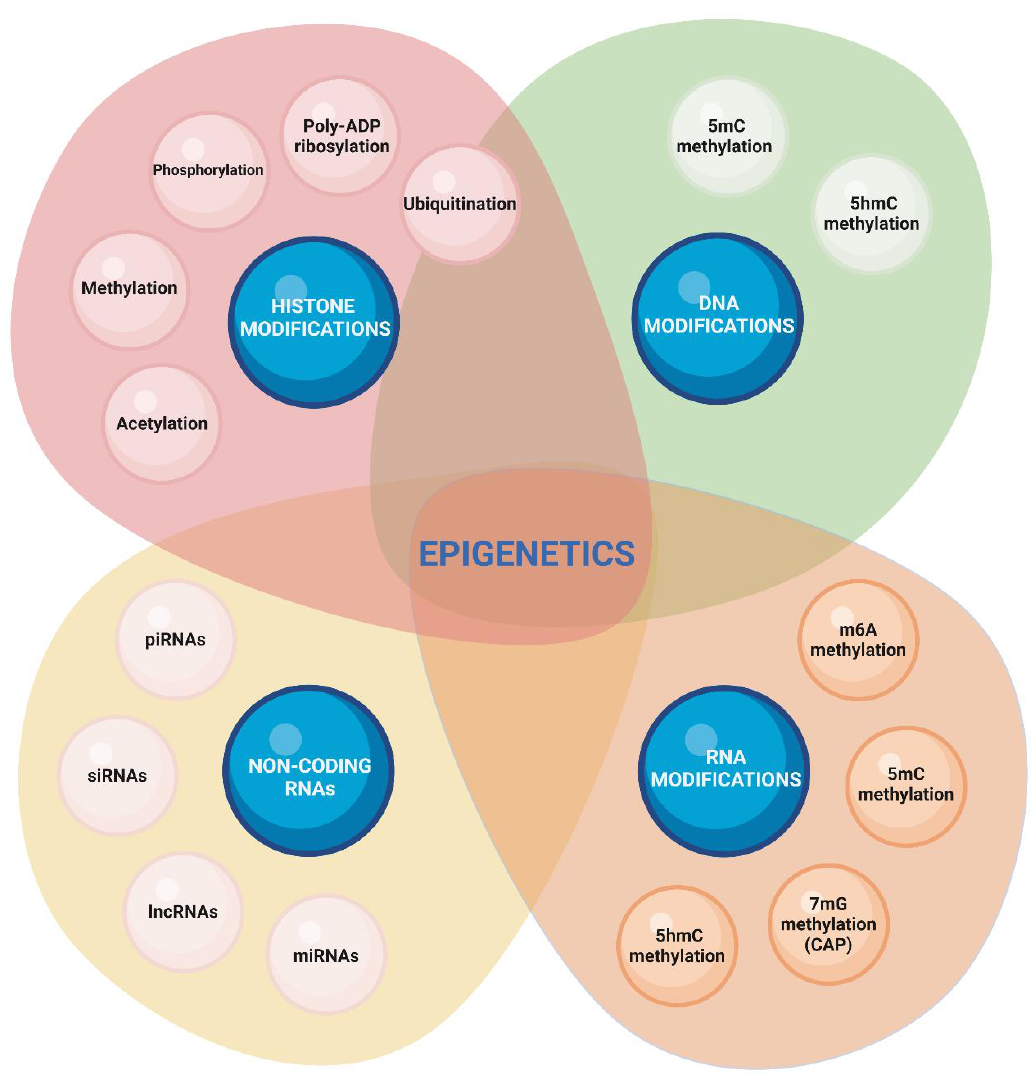
Figure 1. Epigenetic modifications: This diagram shows the complexity of epigenetic processes, which are divided into the following subgroups: DNA modifications — 5-methylcytosine (5mC) DNA methylation, 5-hydroxymethylcytosine (5hmC) DNA methylation; Histone modifications — Acetylation, Methylation, Phosphorylation, Poly-ADP ribosylation, Ubiquitination; Non-coding RNA interactions — piwi RNA (piRNA), small interfering RNA (siRNA), long non-coding RNA (lncRNA), micro RNA (miRNA); RNA modifications—6-methyladenosine (6mA) RNA methylation, 5-methylcytosine (5mC) RNA methylation, 7-methylguanosine (7mG) RNA methylation, mRNA CAP, 5-hydroxymethylcytosine (5hmC) RNA methylation. The image was created with BioRender.com. DNA methylation is the most studied epigenetic mechanism and plays a key role in transcriptional repression/activation (Figures 1 and